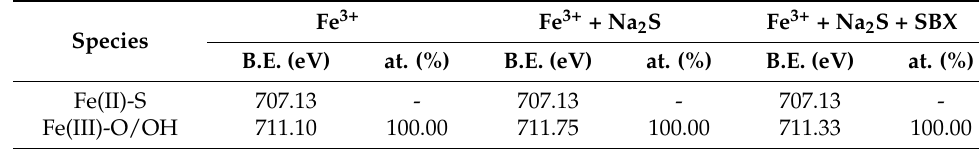
Table 3. Fe 2p quantification of digenite with different treatments in the presence of Fe 3+ .